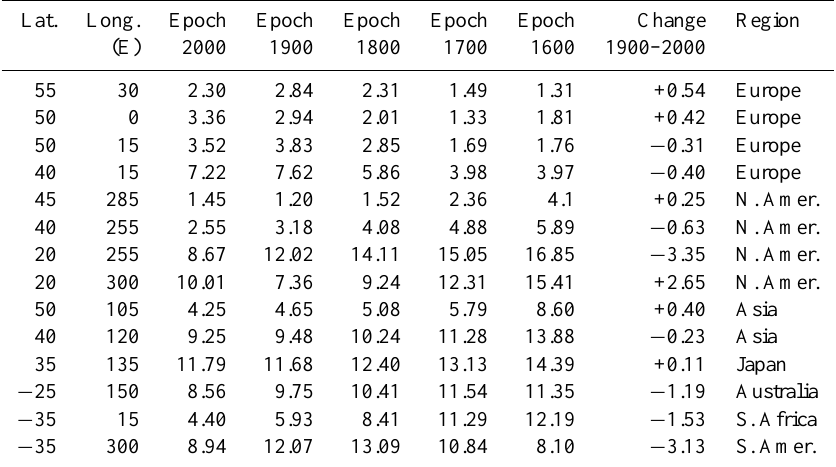
Table 2. Vertical cutoff rigidities R C (in GV) for epochs 1600, 1700, 1800, 1900, and 2000, as well as change from 1900 to 2000. According to Shea and Smart (2003). Lat. Long. Epoch Epoch Epoch Epoch Epoch Change Region